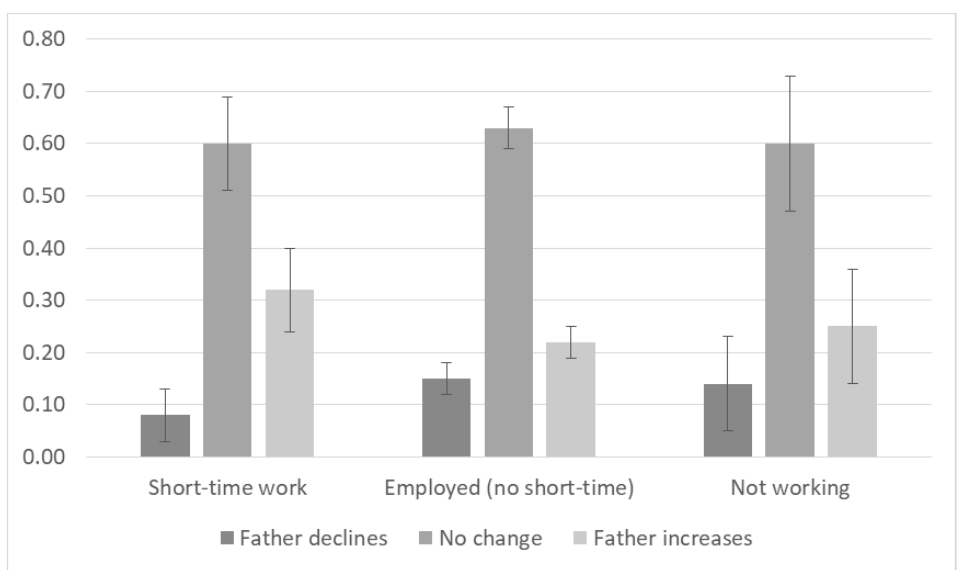
Figure 2 : Average predicted probabilities from multinomial regression model, male